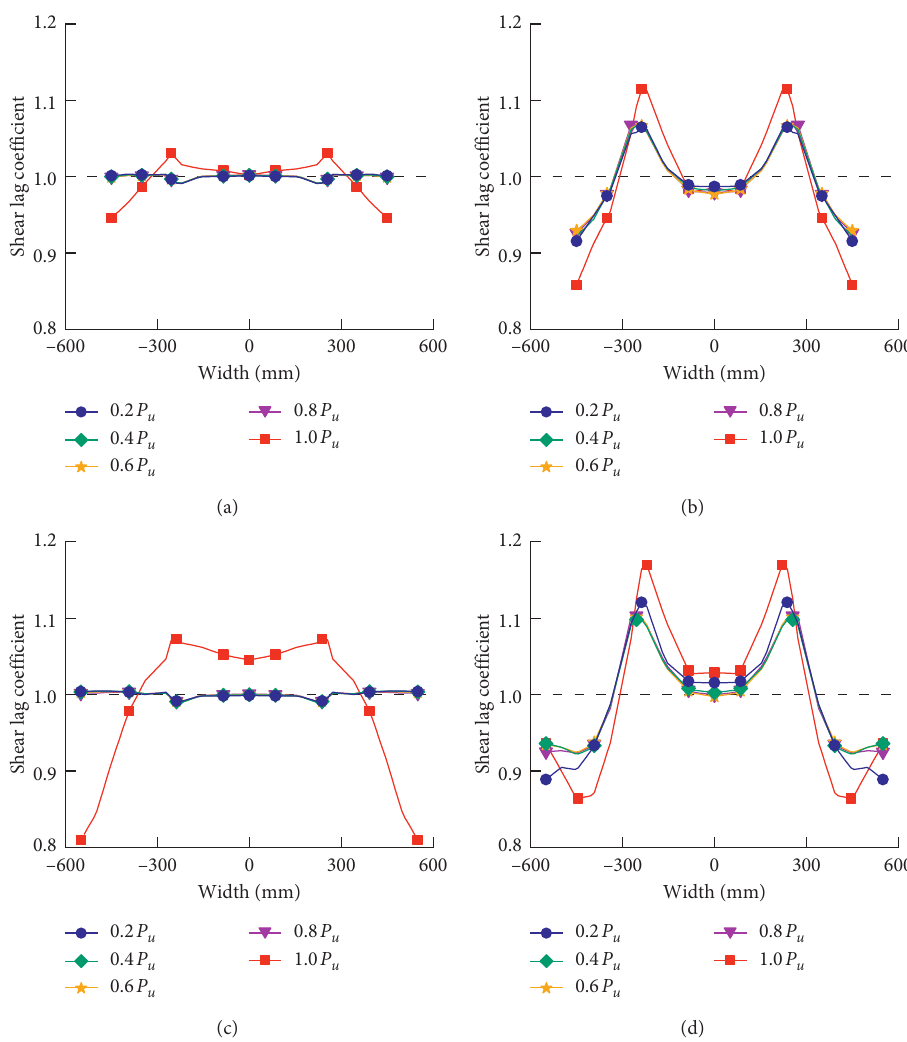
Figure 15: Distribution of shear lag coefficient. (a) Section A-A for S1. (b) Section B-B for S1. (c) Section A-A for S11. (d) Section B-B for S11.